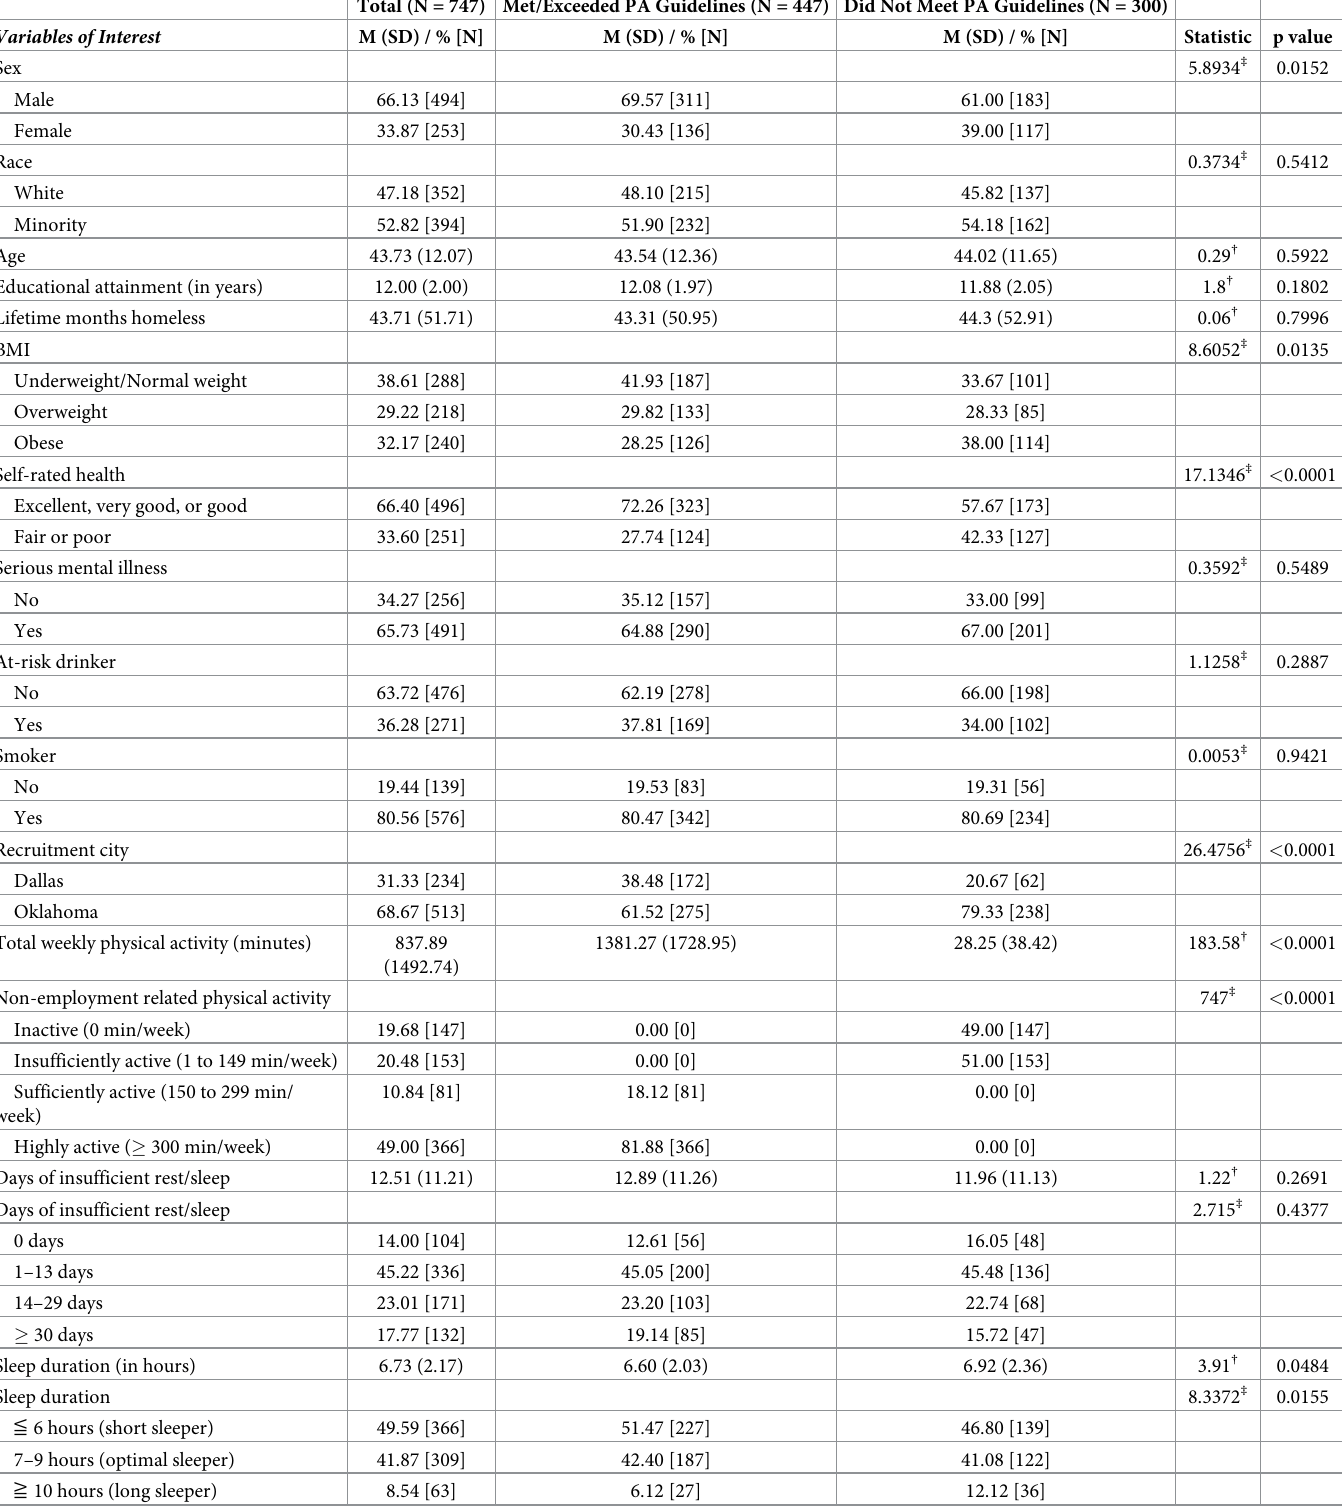
Table 1. Participants’ characteristics by physical activity (PA) guideline adherence (N =